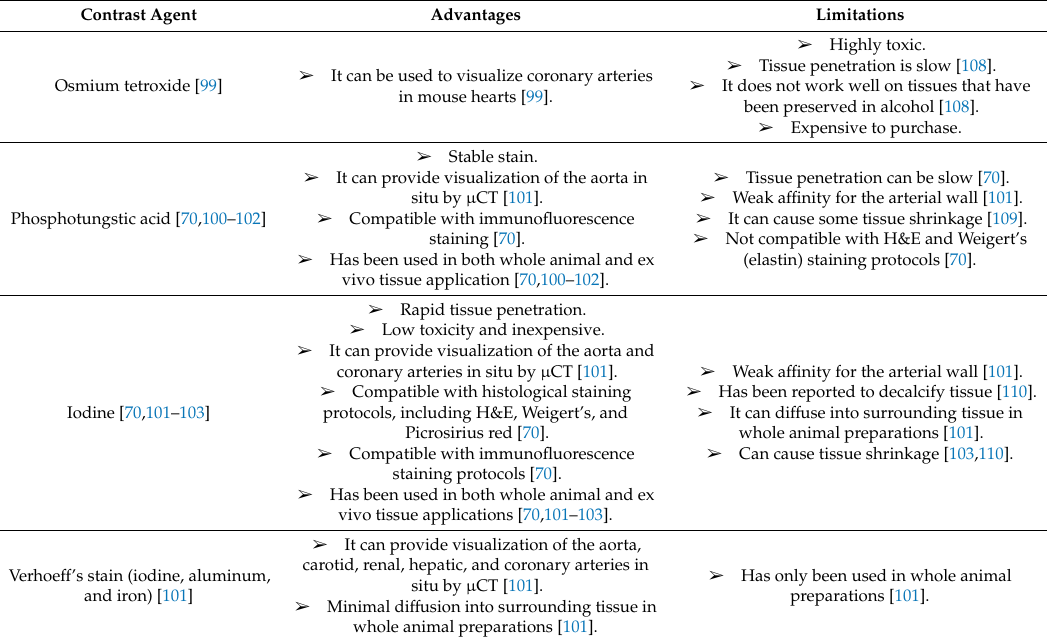
Table 2. Overview of some of the X-ray contrast agents which have been used in vascular studies. Contrast Agent Advantages Limitations Osmium tetroxide